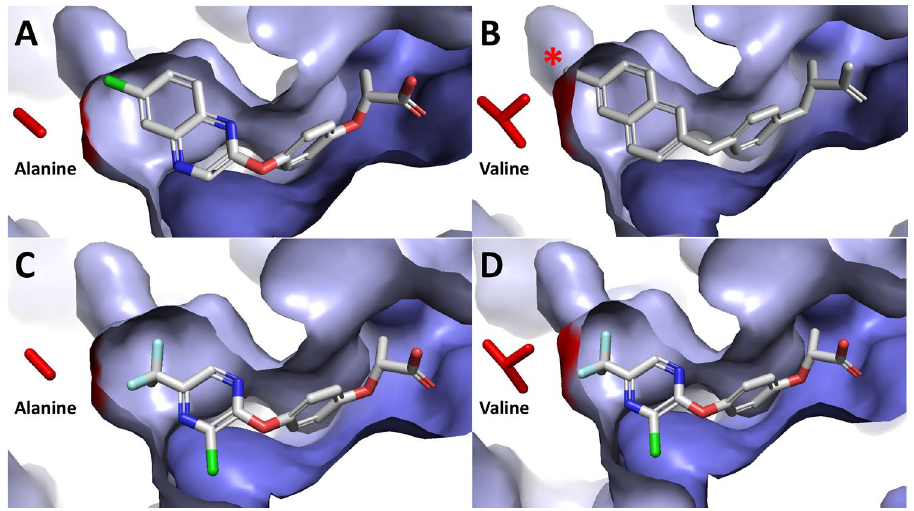
Figure 5. Conformational change caused by the alanine to valine amino acid substitution at position 2004 affects the binding of quizalofop to the carboxyl transferase domain of ACCase. Docking of quizalofop and haloxyfop in the wild-type wheat carboxyl transferase domain are shown in panels ( A , C ) with the methyl group of the alanine side chain shown in red. Changes to the binding cavity caused by the valine substitution (isopropyl group in red) are shown in panels ( B , D) . The small reduction in the volume of the binding domain introduces strong steric hinderance (as denoted by asterisk) that prevents quizalofop from binding (panel C ). The structure of quizalofop is shown in white solely illustrate the steric hindrance because the herbicide no longer binds in this domain. On the other hand, the valine mutation does not interfere with haloxyfop binding (panel D ). Images were generated using PyMOL version 2.3.3 (Schrödinger, New York, NY 10036) (https:// www. schro dinger. com/ produ cts/